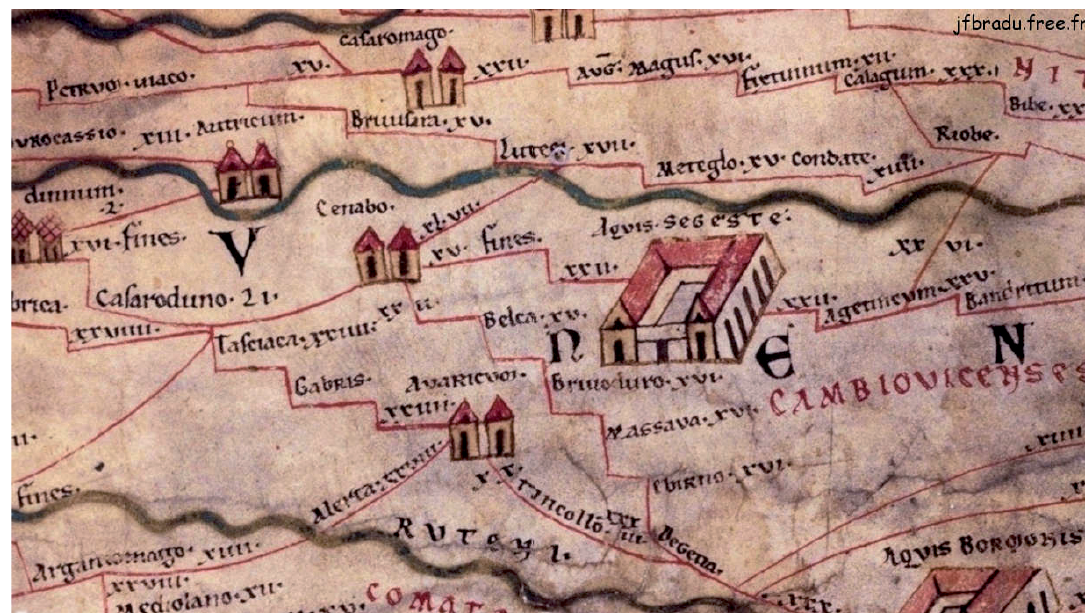
Figure 4. Cenabum (Orleans), Autricum (Chartres), Lutecia (Paris), Aquis Segeste (Sceaux-du-Gâtinais) and Agedincum (Sens) on the Peutingerian Map (Segment